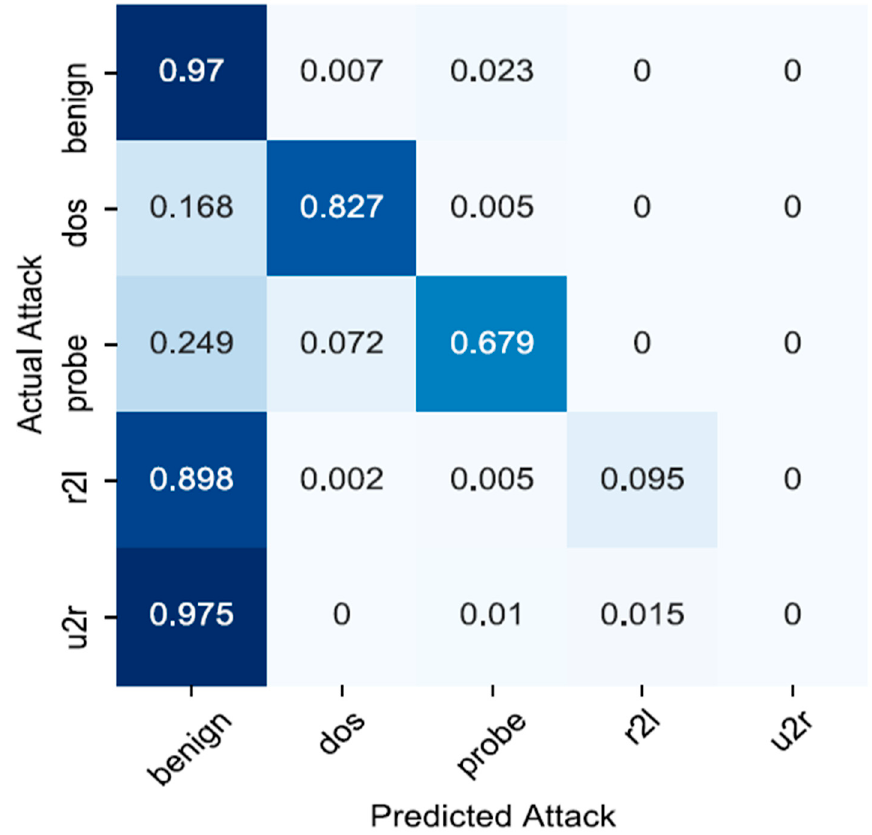
Figure 7. The performance analysis using Confusion Matrix on NSL ‐ KDD dataset.